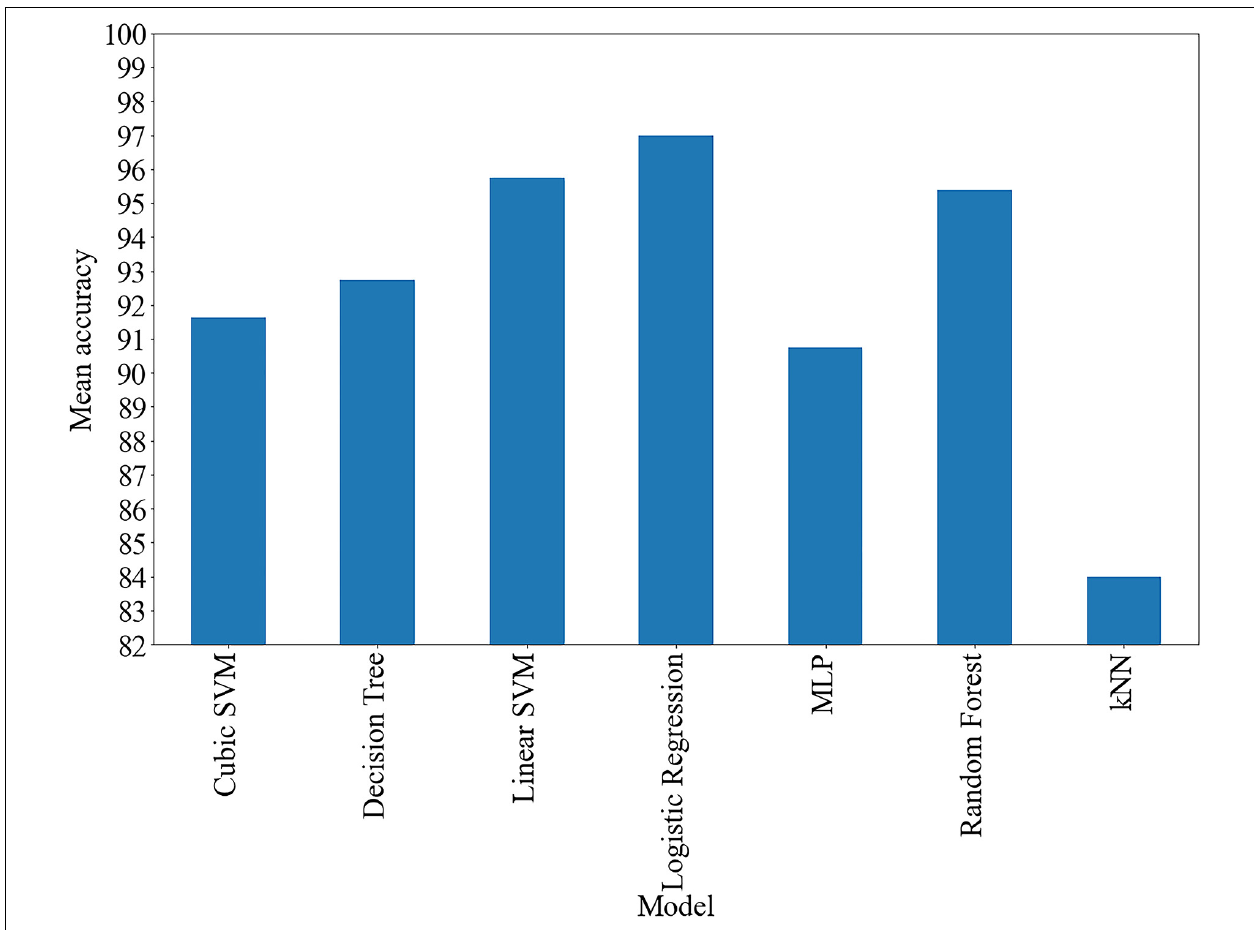
FIGURE 2 | Average of accuracies of separate classifiers.